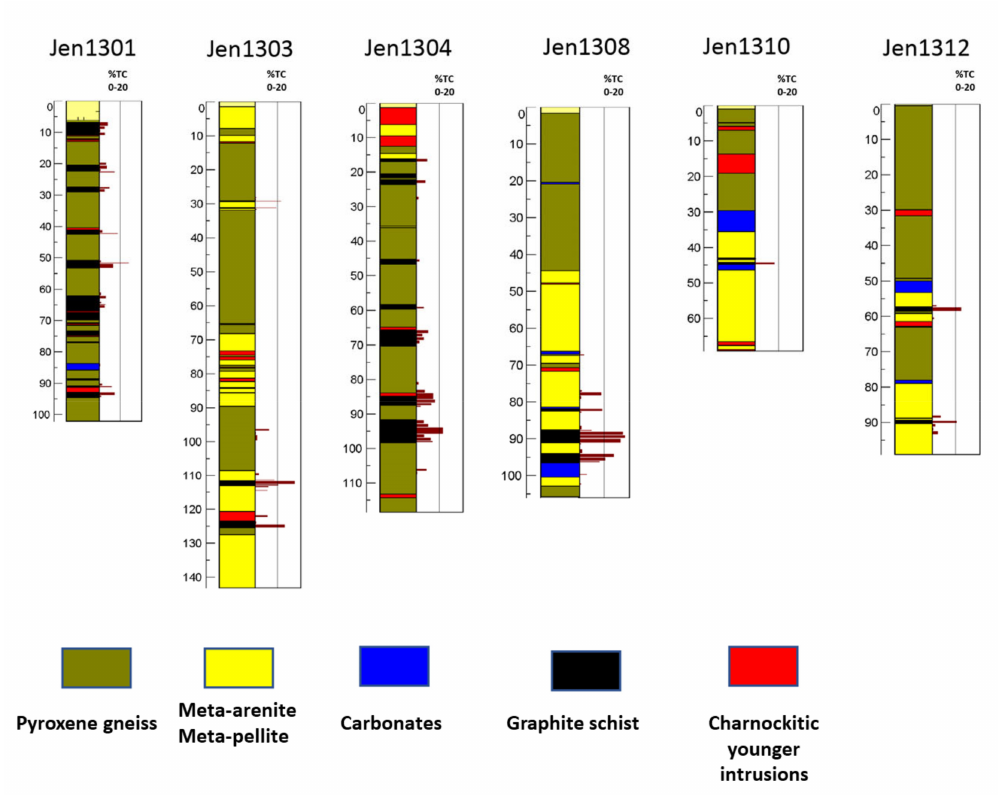
Figure 4. Selected drill logs based on data from Norwegian graphite (near Jennestad, occurrence 25), which show the variation and distribution of pyroxene gneisses, meta-arenite, carbonates, and graphite schist in about 100 m continuous sections together with variation in TC (compiled and simplified from Norwegian graphite, see Supplement data for